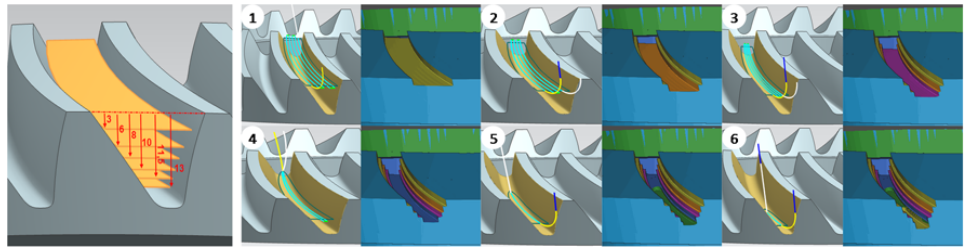
Figure 7. R ‐ II roughing strategy.